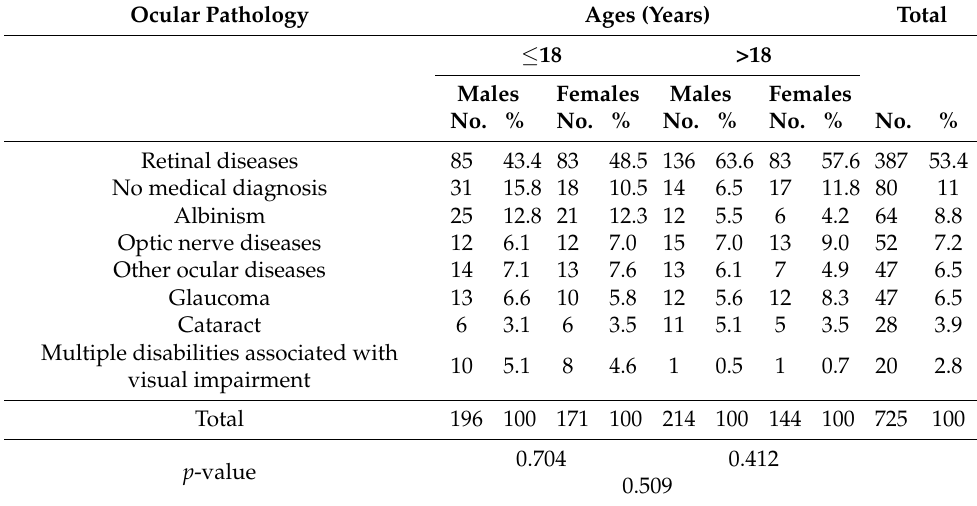
Table 2. Distribution of age and gender of the service users based on their ocular pathology.